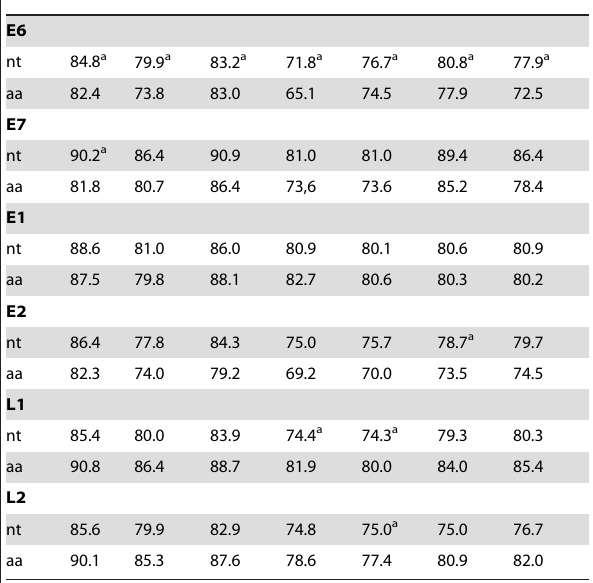
Table 1. Percentage similarity between E6, E7, E1, E2, L1, L2 genes of HPV-125 and closely related HPVs from species 2 of Alphapapillomaviruses .